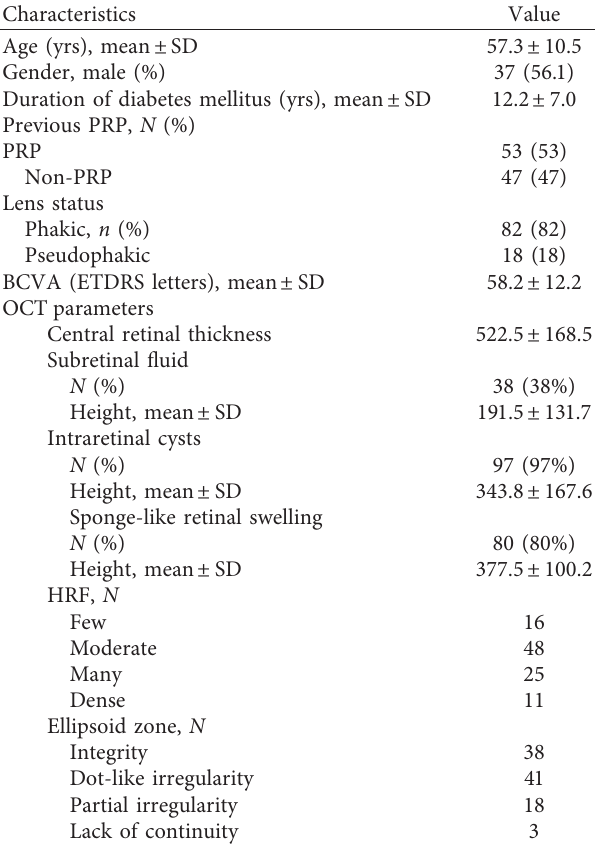
Table 1: Descriptive characteristics of the enrolled patients and the OCT